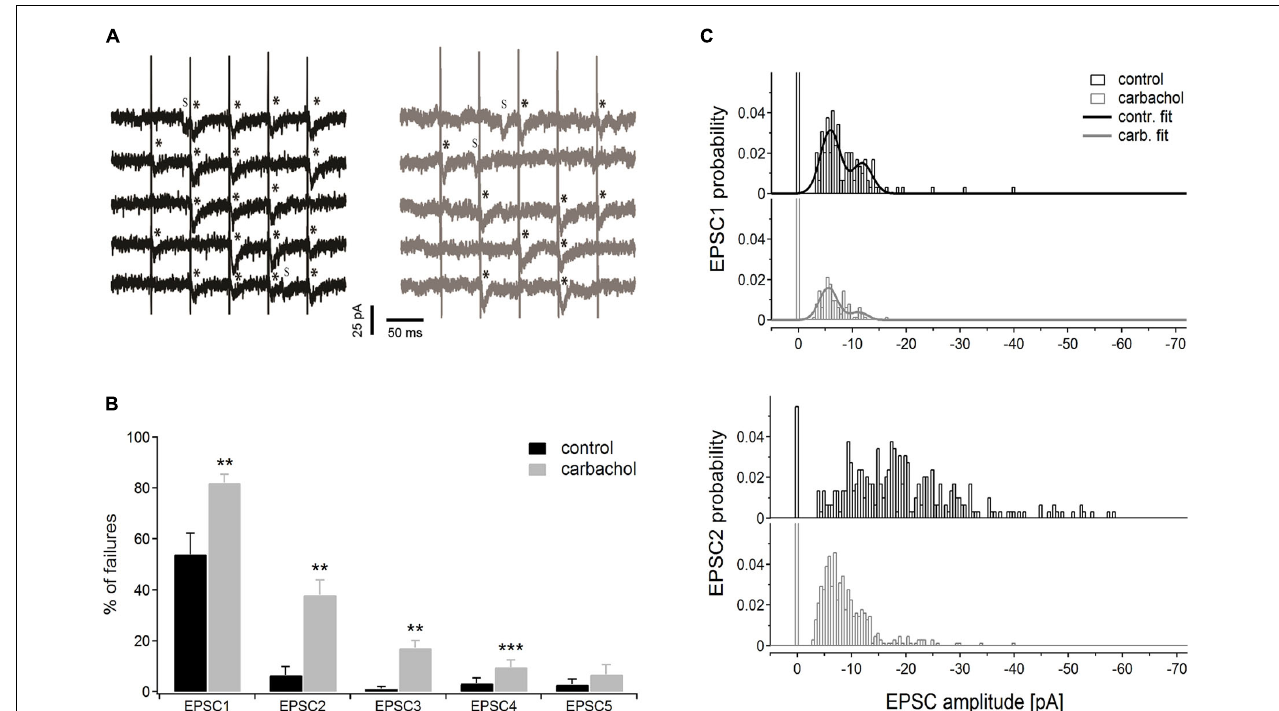
FIGURE 5 | Pseudominimal stimulation experiment ( n = 6 PoM cells). (A) Examples of the unitary excitatory postsynaptic currents (EPSCs) evoked in a single cell by trains of five pseudominimal stimulation of the corticothalamic fibers in the control condition (with ACSF containing GABA inhibitors, black traces on the left) and after application of 6–8 µ M carbachol (gray traces on the right). Successively evoked EPSCs are marked with asterisks (*), letter “s” indicates the spontaneous EPSCs. (B) Percentage of the failures averaged for a group of cells in the control condition and after adding carbachol. (C) Histograms showing amplitude distribution for 1st (upper panel) and 2nd (lower panel) EPSCs in the train, in control conditions and with the addition of carbachol. Bars drawn at zero of the abscissa axes indicate probabilities of failures. Continuous black and gray curves on EPSC1 histograms show the appropriate double Gaussian fits. Data are expressed as mean ± SEM, ** P ≤ 0.01, *** P ≤